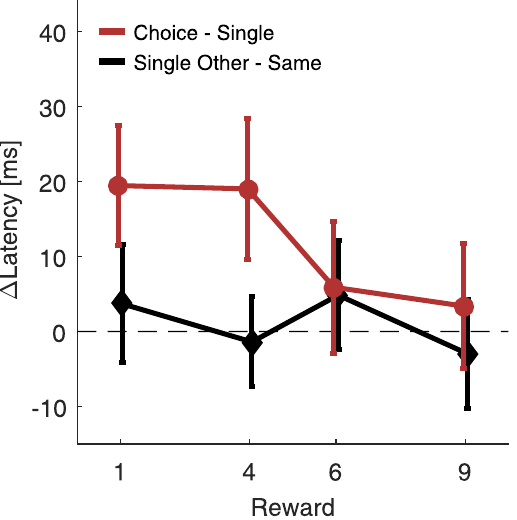
Figure 3. Inhibition of the non-chosen target. N-1 effects from Experiment 1. The difference in single-trial latency when the previous trial was a choice- compared to a single-trial (red circles). After a choice-trial, latencies to less rewarded single-targets, thus to the non-chosen target, are increased. This cannot be attributed to a change in saccade direction, because no such delay occurs when the previous trial was a single-trial in the opposite versus the same direction (black